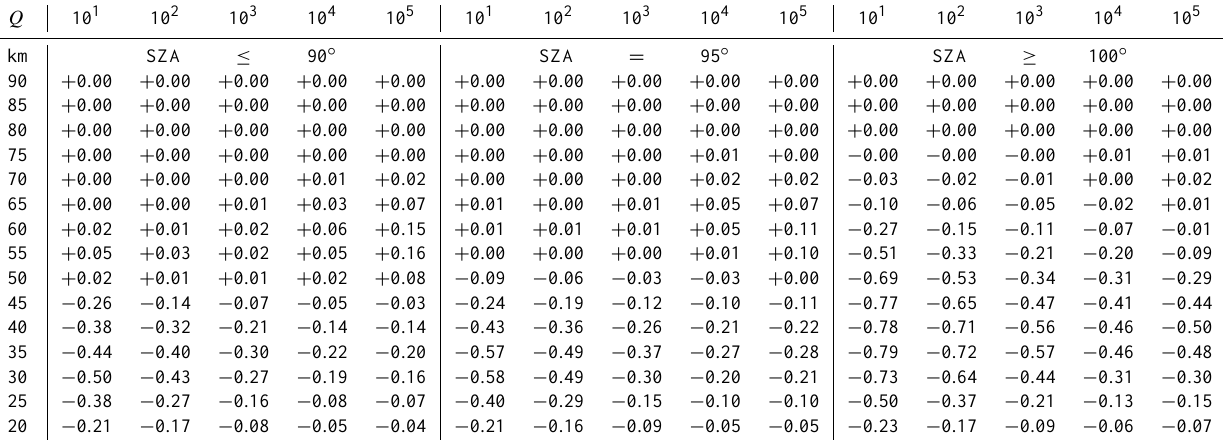
/Q for October NH. 2